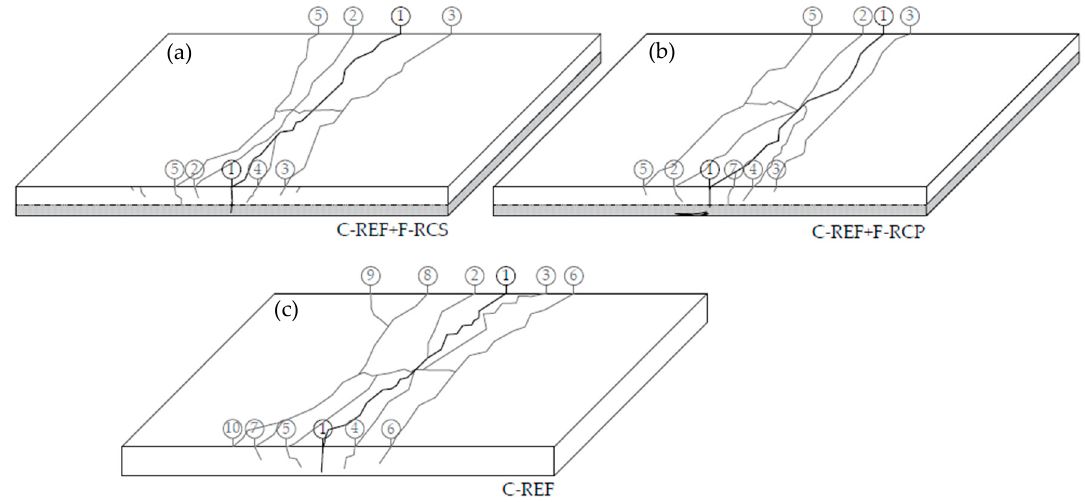
Figure 15. Correlation between flexural strength and ultimate load.